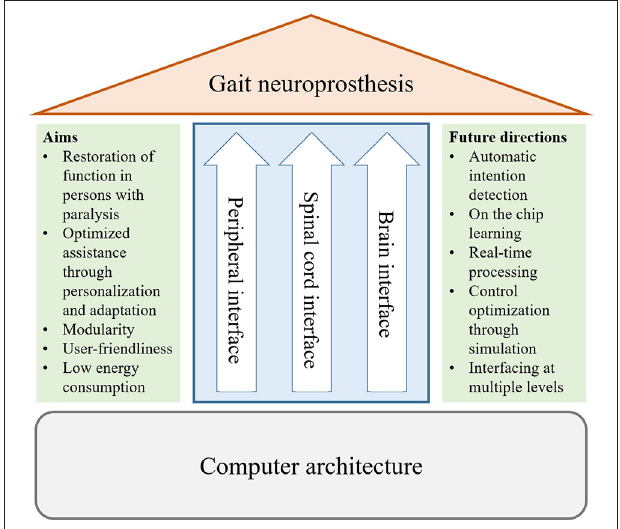
FIGURE 2 | Overview of the topics of this perspective on gait neuroprostheses. We discuss requirements and future directions for interfaces with the periphery and the central nervous system (brain and spinal cord), as well as for the computer